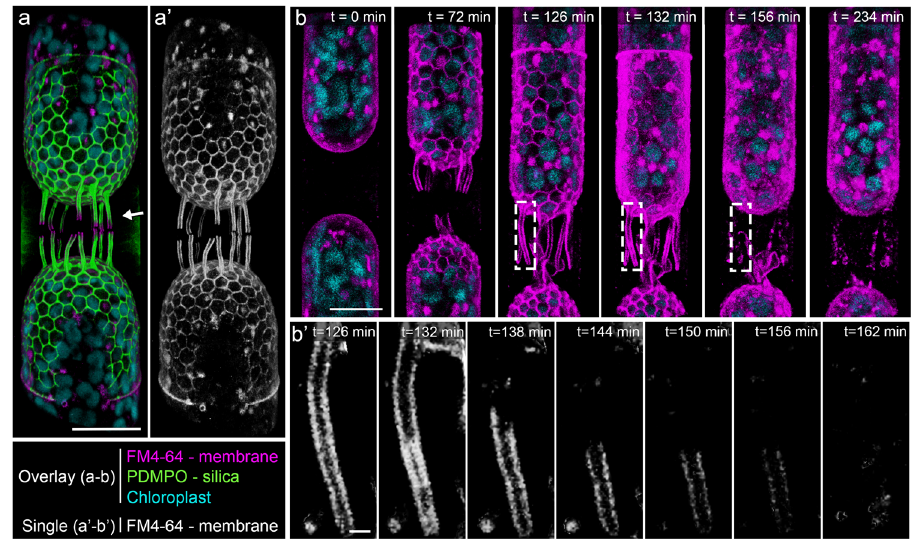
Fig.2|3Dreconstructionsoftime-lapseconfocal fl uorescenceimagesshowing coordinatedsilicaandmembranedynamicsduringvalveformationin S.turris . a , b Overlay images of fl uorescence channels. a ’ , b ’ Single channel FM4-64 fl uor- escenceimages. a – a ’ DaughtercellsduringvalveformationlabeledwithbothFM4- 64 and PDMPO. Membranes outline the growing polygons and lead the growth of linking extensions (arrow). b Snapshots from a time-lapse of daughter cells going